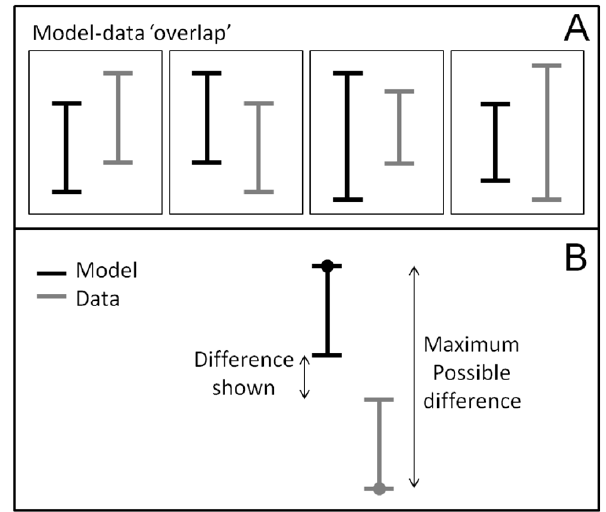
Fig. 3. Model–data comparison definitions. Panel (A) shows the definition for “overlap” used in the model–data comparison: all four instances shown are considered as an overlap. Panel (B) shows that although we define model–data mismatch as the minimum possi- ble distance to overlap, the maximum possible differences could be much greater if the true values for both the model and the data were to lie at the extremes of the uncertainty